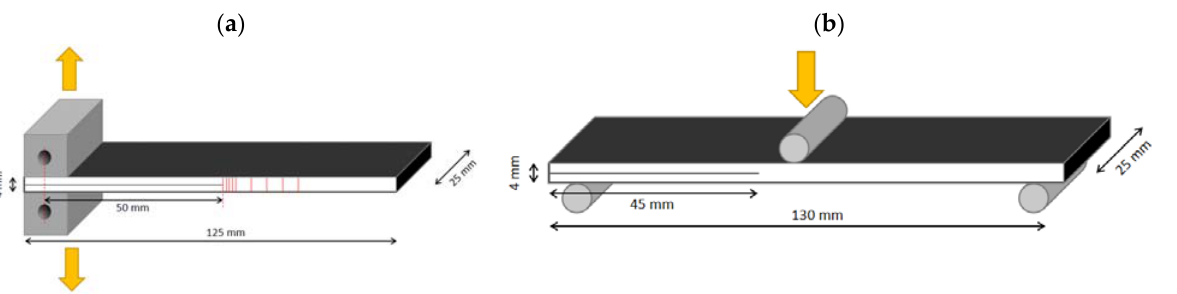
Figure 1. ( a ) DCB and ( b ) ENF geometries for the evaluation of the interlaminar fracture toughness.